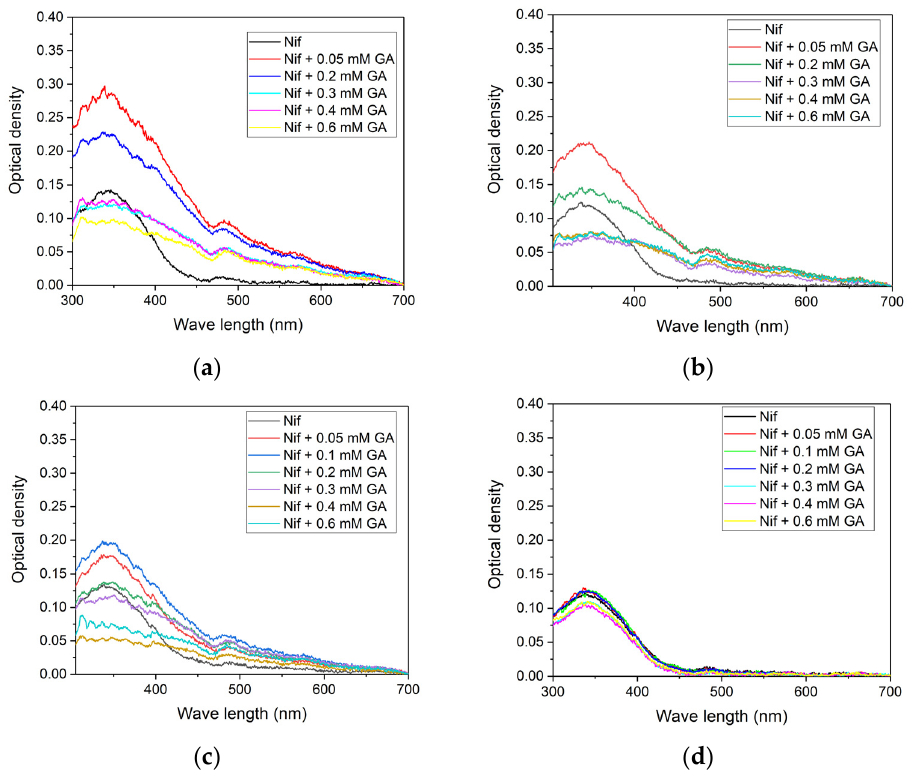
Figure 2. Optical absorption spectra of the mixture nifedipine + GA at pH value ( a ) 3.8, ( b ) 4.2, ( c ) 4.9, and ( d ) 9.5. The GA absorption is subtracted from all spectra. Nifedipine was added in an amount exceeding the maximum solubility in water (0.5 mM was added).